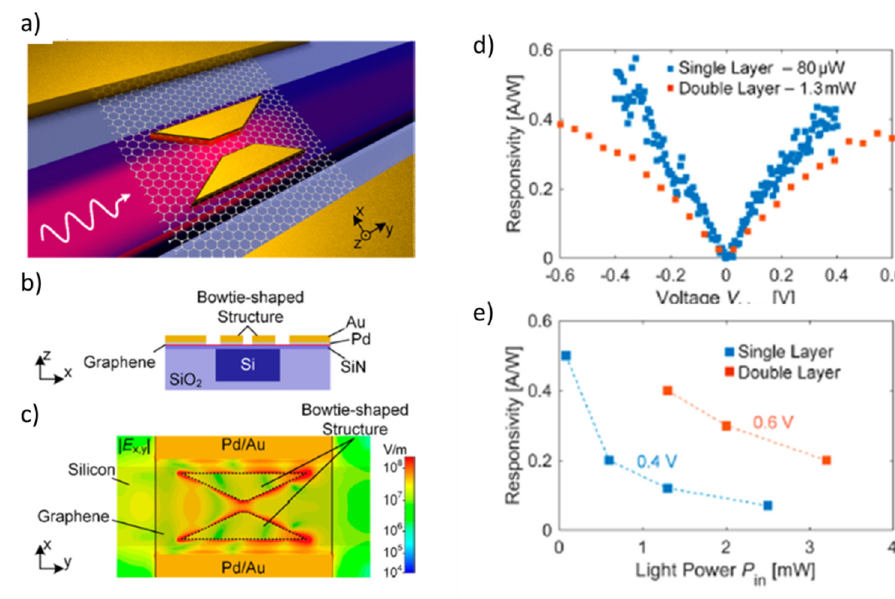
Figure 5. Plasmonically enhanced waveguide-integrated graphene PD. ( a ) 3D perspective view of the PD. ( b ) Cross sectional view of the graphene PD. ( c ) In-plane view of the magnitude of Ex and Ey electric fields, obtained by 3D full-wave finite-element method (FEM) simulations. ( d ) Responsivity of the PD as a function of bias voltage for a single-layer (blue scatters) and a double-layer graphene device (red scatters). ( e ) Responsivity of the PD as a function of light input power. (Adapted from [112]).